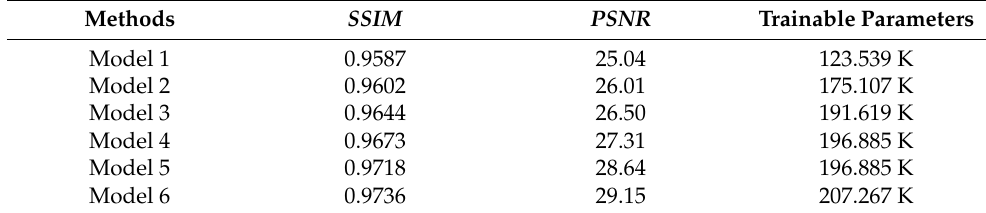
Table 5. Result of ablation analysis on RESIDE SOTS outdoor dataset.